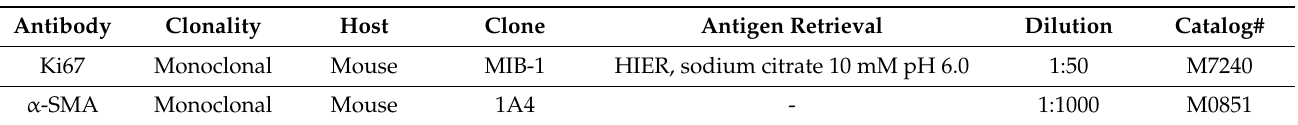
Table 1. List and details of antibodies used in this study for immunohistochemistry (HIER, heat-induced epitope retrieval; α -SMA, alpha smooth muscle